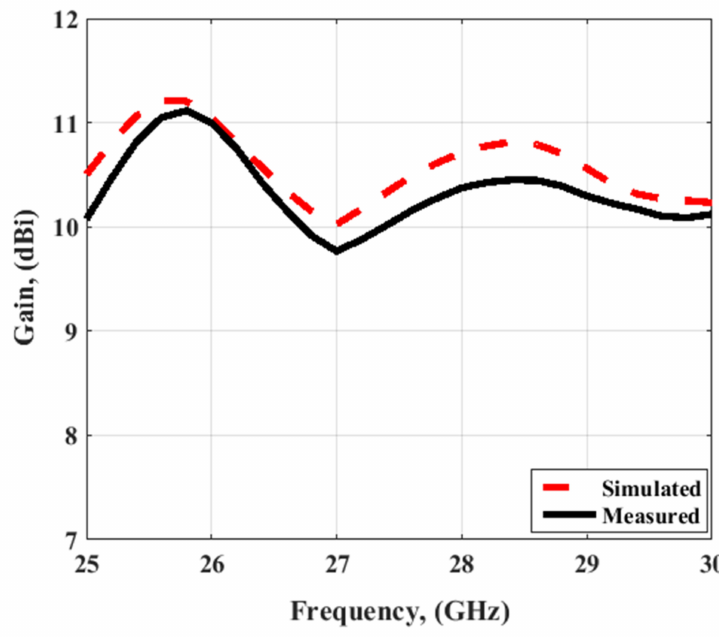
Figure 9. Gain variation versus frequency for the 1 × 4 antenna array.